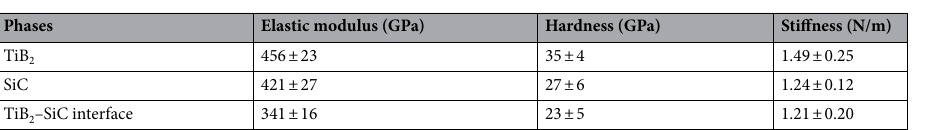
Table 2. Stiffness, elastic modulus, and hardness of different phases in the C f -incorporated TiB 2 –SiC composite.